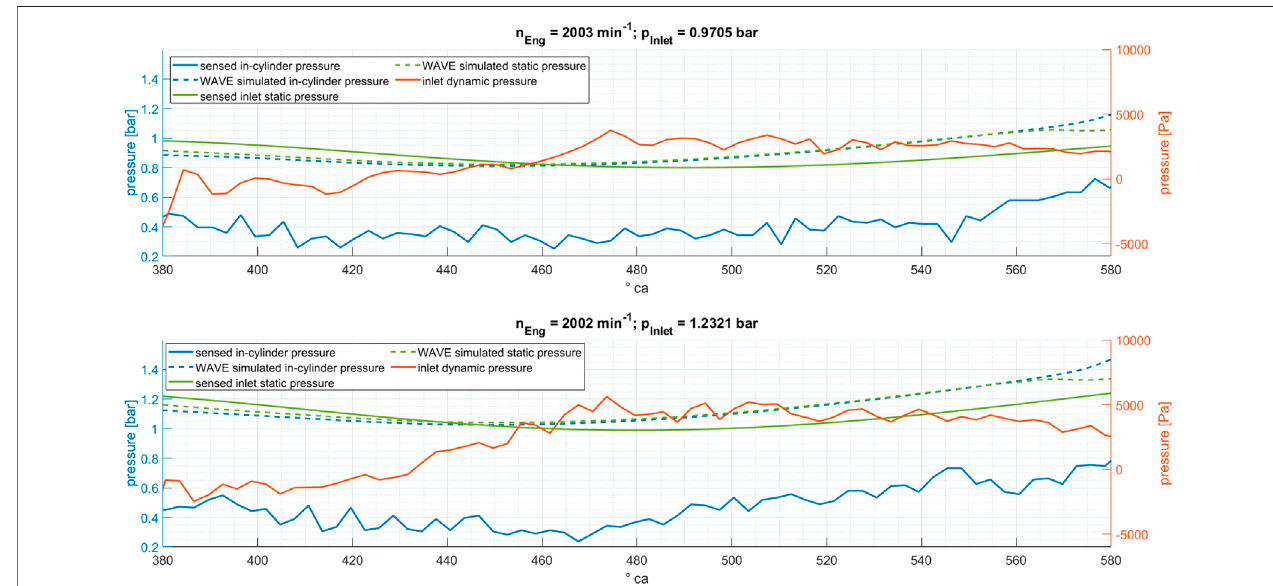
FIGURE11| Thestatic anddynamicpressure intheinlet duct alongwiththe in-cylinder pressurezooming inthe intakevalve opening durationat the enginespeed of 2000 rpm. Top graph: naturally aspirated mode; Bottom graph: boosted conditions.